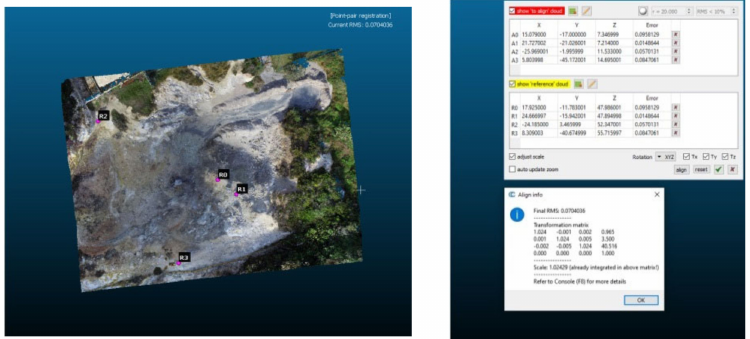
Figure 6. Alignment procedure with the Cloud Compare